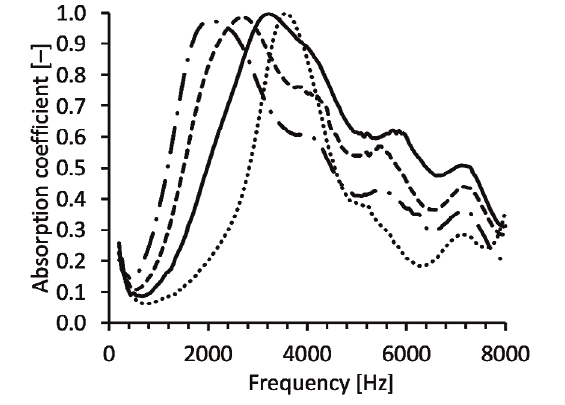
Fig. 11. Absorption coefficient for one microperforated plate (material B), distance X1 was set from 0 mm (dotted line) to 15 mm (dash-dotted line).